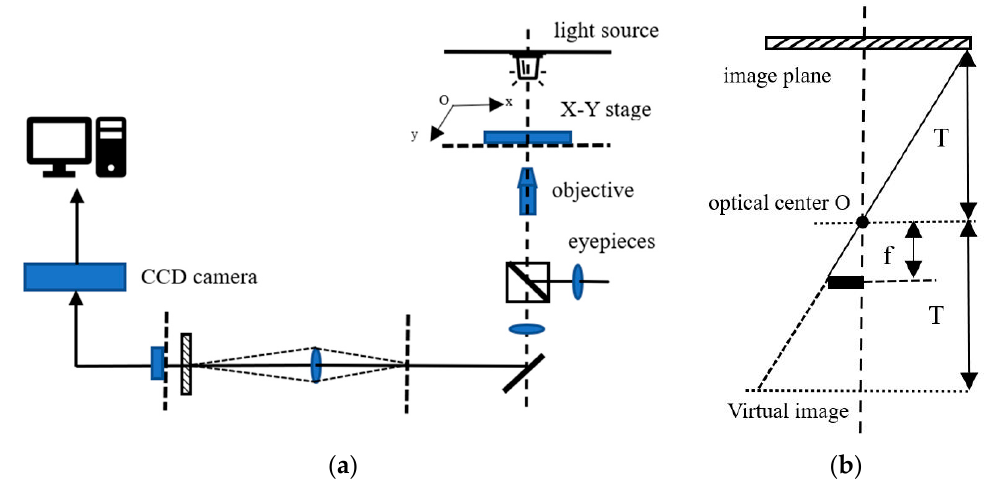
Figure 3. The vision system and simplified imaging model of the micromanipulation system. ( a ) The diagram of the vision system, ( b ) The simplified imaging model. T is the working distance of the microscope and f is the focal length of the objective lens.